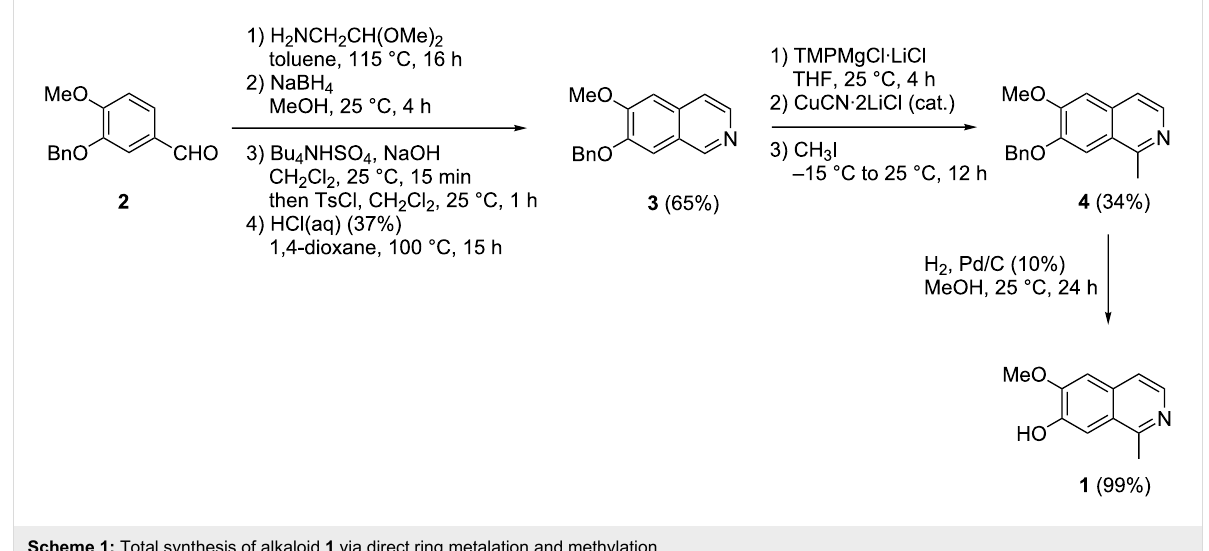
magnesium bromide [17], and direct methylation using